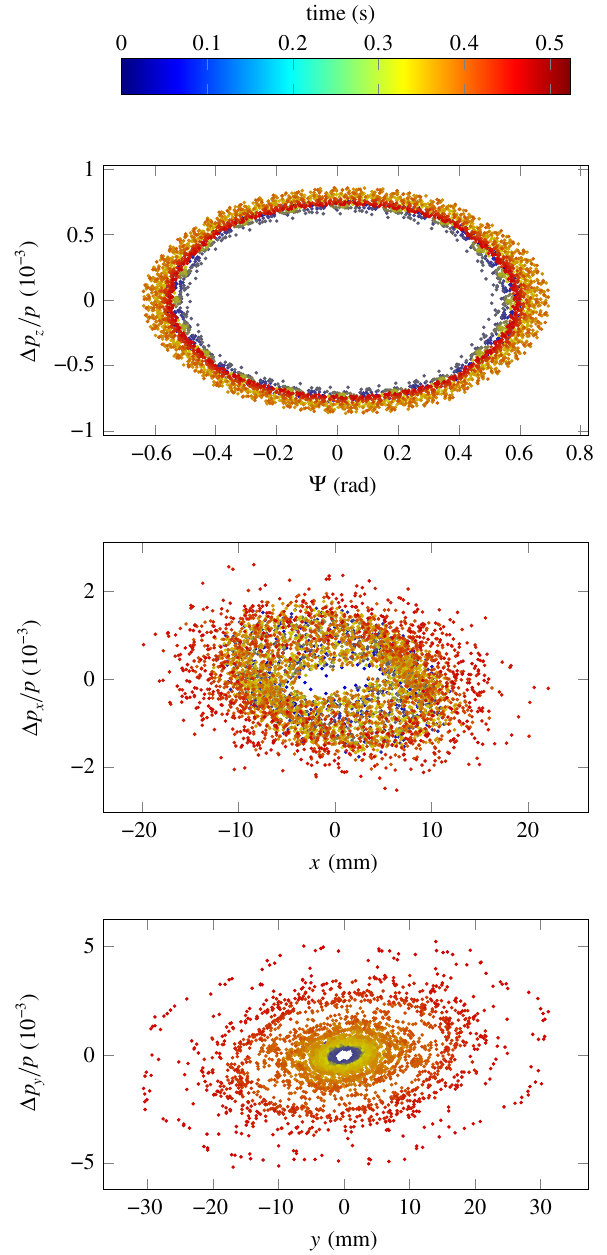
FIG. 18. Phase space trajectory of one example particle placed randomly in 6-d phase space and subjected to cooling bunches with bunch length jitter. The perturbation of the longitudinal motion is inconsequential, while fluctuations of the transverse action eventually lead to a collision with a limiting aperture. The plot only shows every 20th revolution for clarity, whereas collisions with the aperture are checked after each machine element. While the loss of this particle is not obvious, the coordinates are only saved at s ¼ 0 (referring to the lattice shown in Fig. 1); the maximum β x;y functions in the ring are higher than β ð s ¼ 0 Þ by a factor of 1.8 and 4.8, respectively. This particle is x;y marked as lost at t ¼ 0 . 47 s.